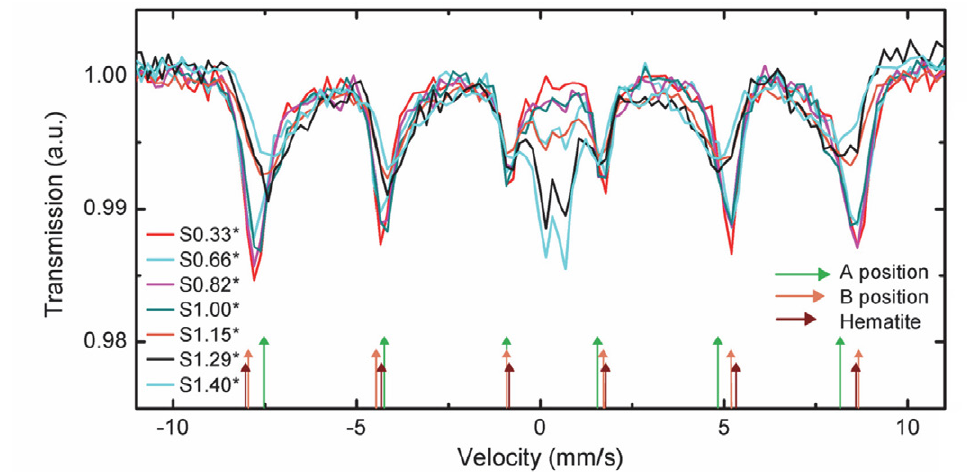
Figure 6. Emission spectra of S0.33*, S0.66*, S0.82*, S1.00*, S1.15*, S1.29* and S1.40* samples.